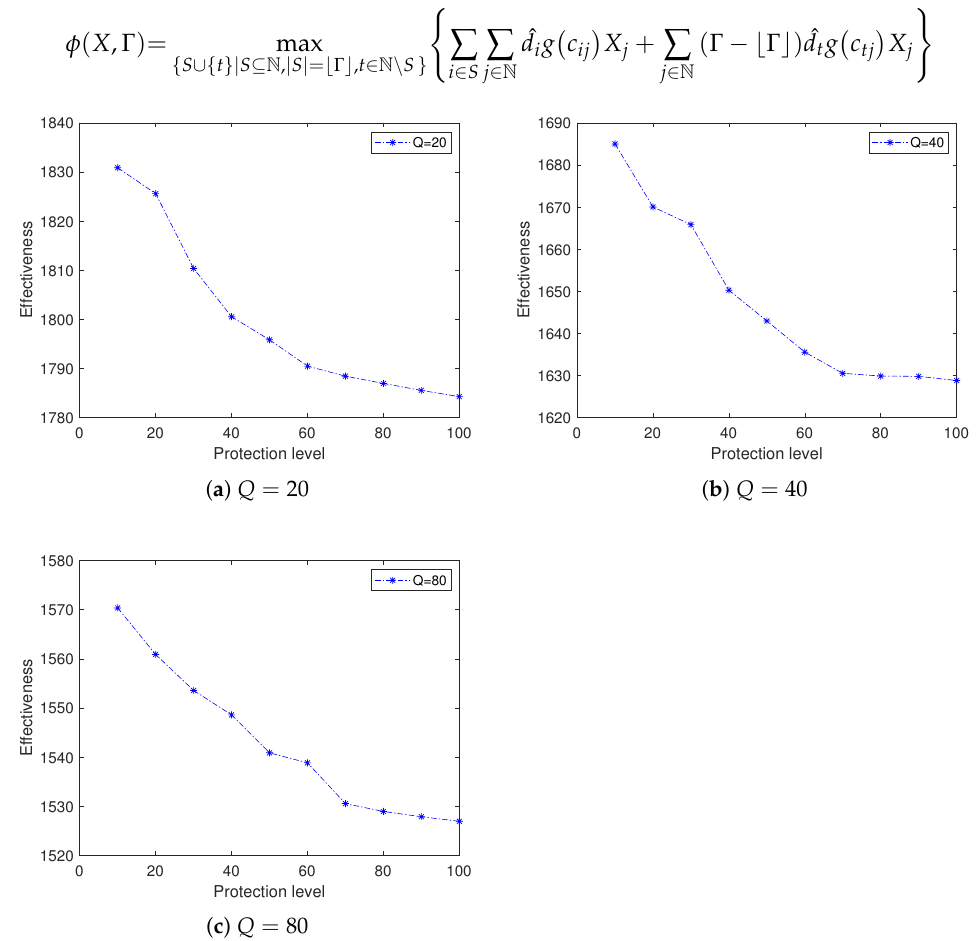
Figure 2. The effectiveness as a function of the protection